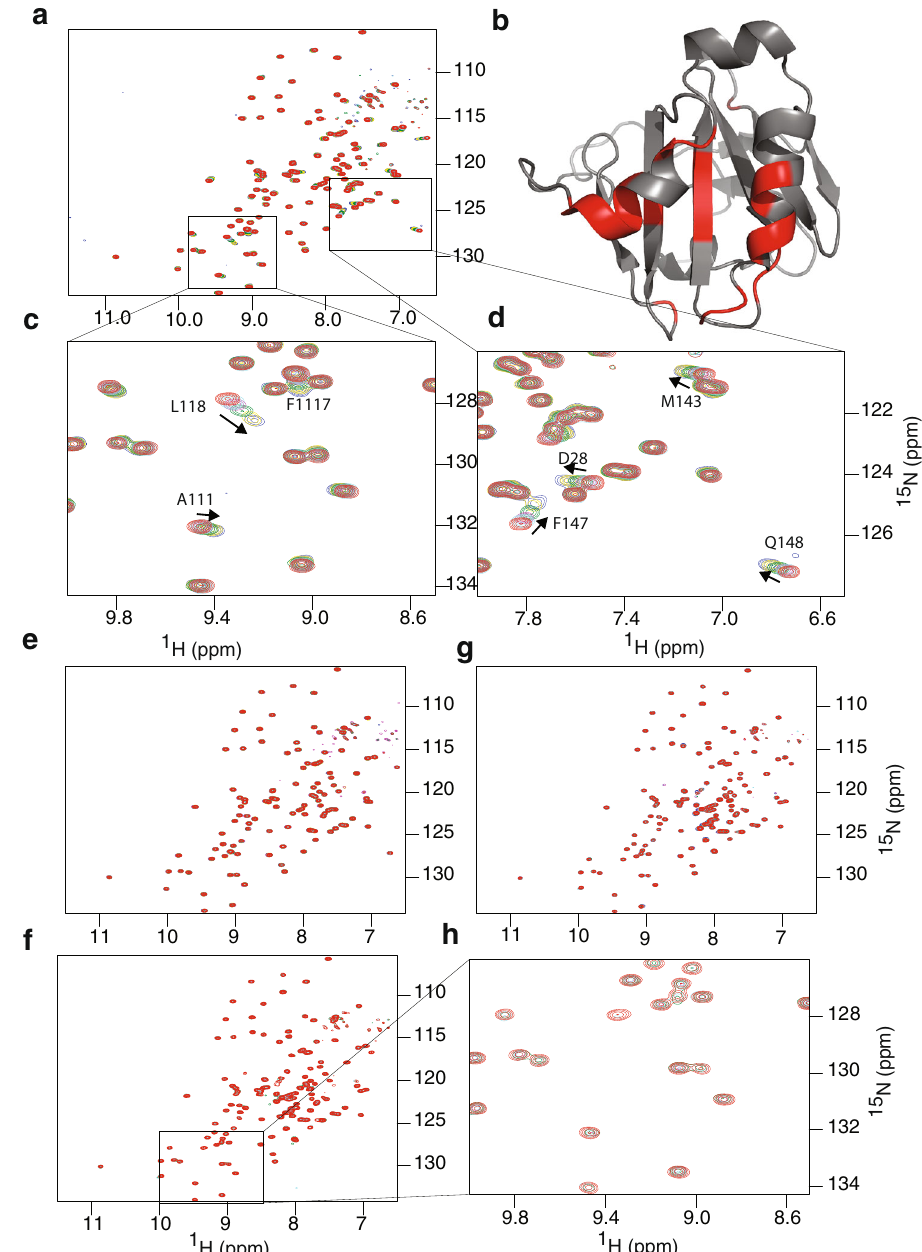
Fig. 7 HeimPro fi lin N-terminal extension is important for interaction with phospholipids. Phosphatidylinositol-4,5-bisphosphate (PtdIns-4,5-P 2 (PIP 2 )) and D-myo-inositol-1,4,5-triphosphate (IP 3 ). a Overlay of 1 H- 15 N TROSY-HSQCs of Δ N-heimPro fi lin (400 μ M) with increasing concentrations of PIP 2 ; 0 μ M (red), 150 μ M (cyan), 300 μ M (magenta), 600 μ M (green), 1200 μ M (yellow) and 2100 μ M (blue). b Structure of heimPro fi lin with the interacting residues color-coded. The interaction site appears to be located between the N-terminal and C-terminal helix. c – d Expansion of ( a ) showing a few residues belonging to the b-strand residues F117-W120 and residues Q110-A111 are also strongly involved in the interaction. e Overlay 1 H – 15 N TROSY-HSQCs of Δ N- heimPro fi lin (300 μ M) with increasing concentrations of IP 3 ; 0 μ M (red) 150 μ M (cyan), 300 μ M (magenta), 600 μ M (green), 1200 μ M (yellow), 2100 μ M (blue). f Similar to ( a ) but with heimPro fi lin and PIP 2 ; 0 μ M (red) 150 μ M (cyan), 300 μ M (magenta), 600 μ M (green). g Similar to ( e ) but with heimPro fi lin interacting with IP 3 ; 0 μ M (red) 150 μ M (cyan), 300 μ M (magenta), 600 μ M (green), 1200 μ M (yellow), 2100 μ M (blue). Little or no chemical shift changes were observed for heimPro fi lin- IP 3 interaction. h Expansion of a region in ( f pro fi lins were able to inhibit actin polymerization in actin pyrene assays. Loki pro fi lin was shown to have a distinctive loop (the Loki-loop) that was absent from the human pro fi lin and that pro fi lins from Loki, Odin, and Heimdall LC2 were able to interact with PIP 2 and inhibit their effect on actin polymerization.